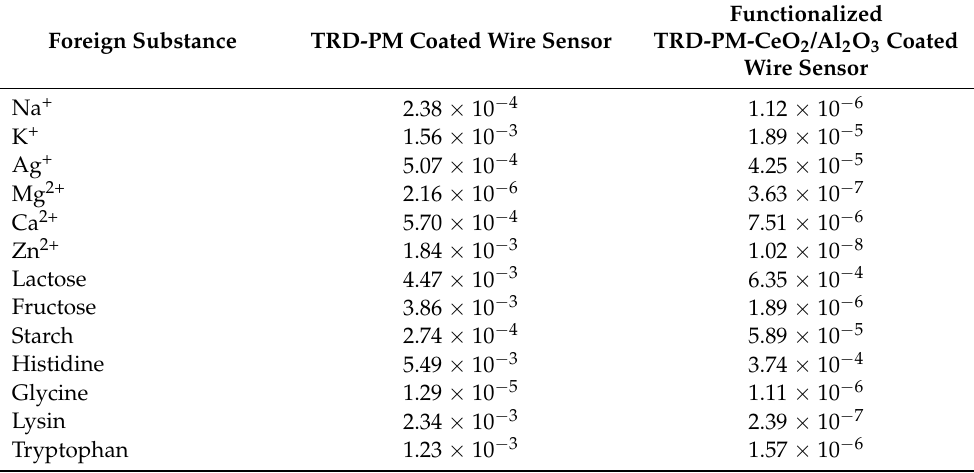
Table 2. Outcomes of tolerable values (K pot TRD+ ) of some interferents determined by the suggested TRD-PM and functionalized TRD-PM-CeO 2 /Al 2 O 3 nanocomposite coated wire sensors using sepa- rate solution